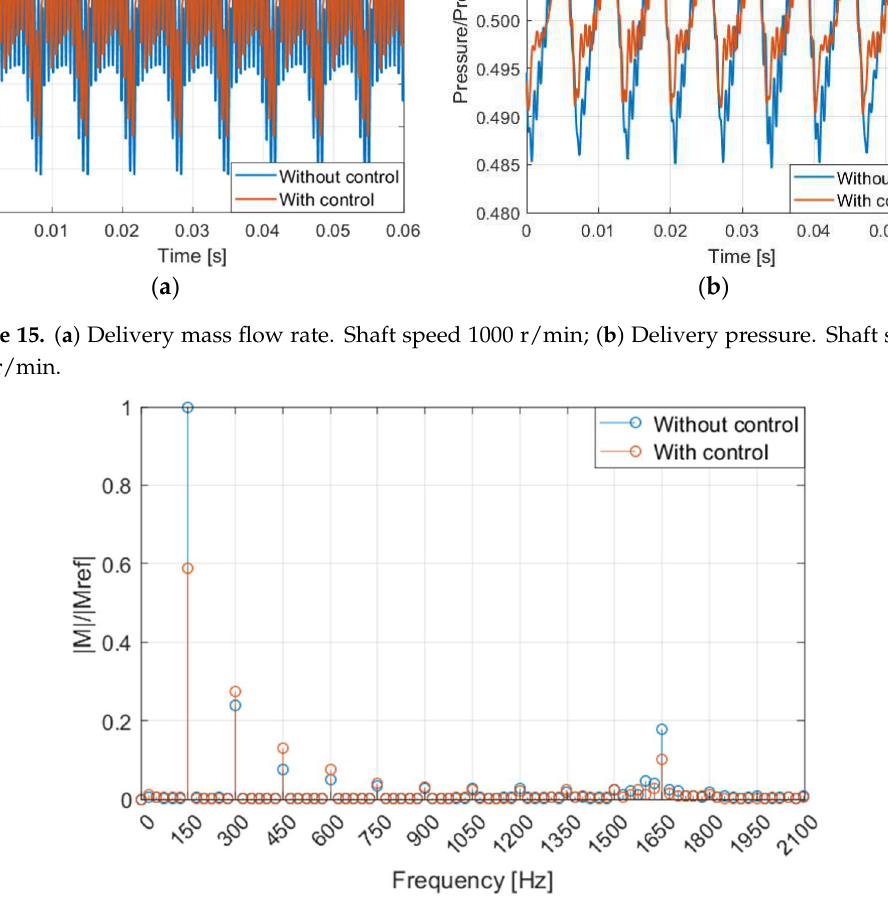
Figure 16. Delivery pressure FFT. Shaft speed 1000 r/min.